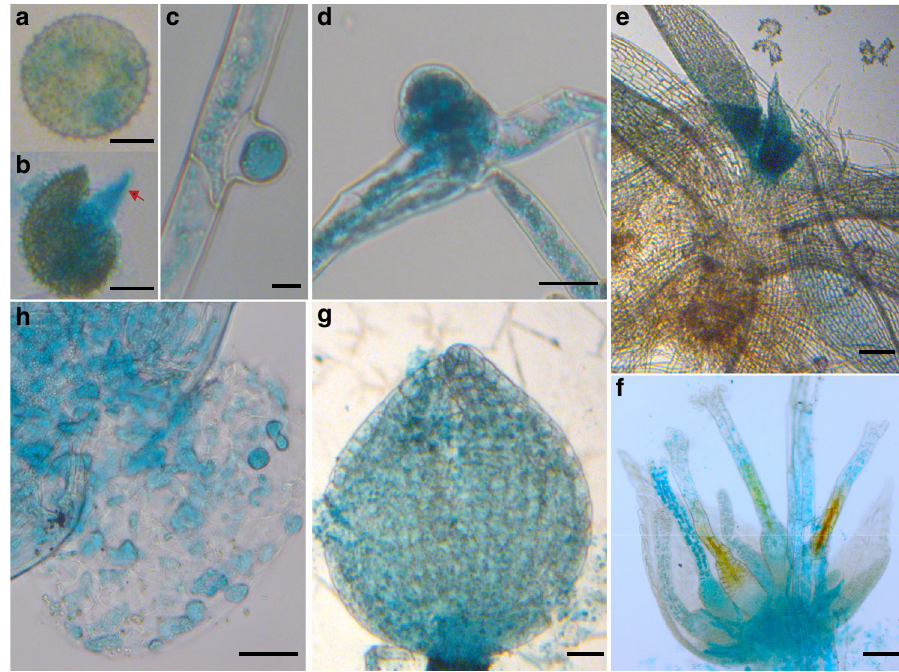
Fig. 4 Expression pro fi le of PpMACRO2 determined by histochemical GUS assays. a Spores. b Germinating spores, with the red arrow indicating the chloronema apical stem cell. c Protonema side-branch apical stem cell. d Juvenile gametophore. e Leafy gametophore. f Developing archegonium, with GUS activity detected in the egg cell as well as in the archegonia tissue. g Sporangium. h Individual spores within sporangium. Micrograph images provided were observed from at least three biological replicates. Scale bars: 25 μ m in a , b ; 100 μ m in c , d , f – h ; 500 μ m in e .